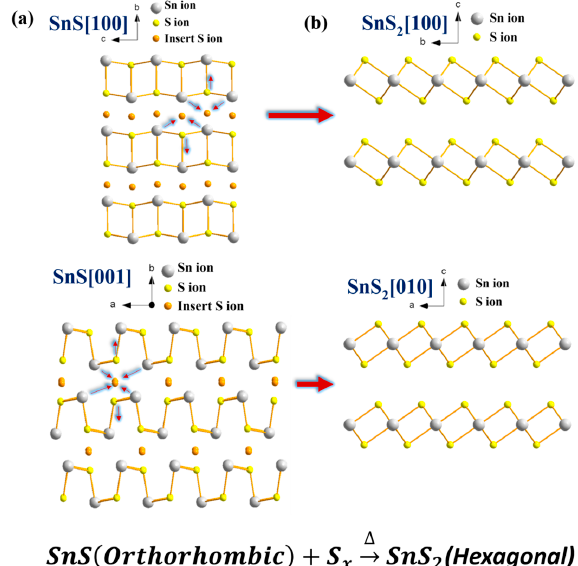
Figure 2. Schematic of proposed growth mechanism for the phase transition process of SnS to SnS 2 via sulfurization. Different sectional views of atomic arrangements of: ( a ) orthorhombic SnS; and ( b ) hexagonal SnS 2 (atom color: gray, tin; yellow, sulfur; orange, insert sulfur).